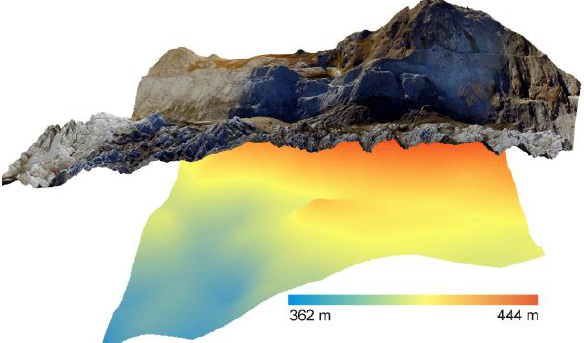
Figure 7. 3D model of glacier surface (overlain by orthomosaic) and subglacial